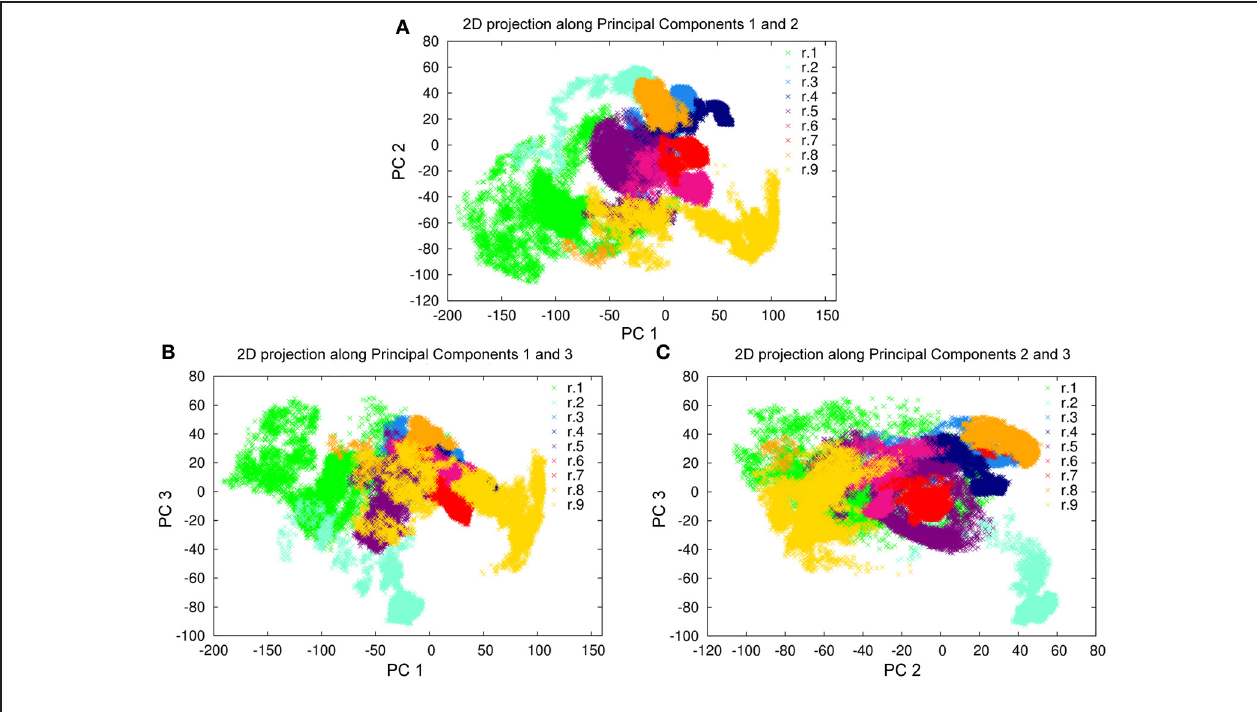
FIGURE 3 | Projections of the MD trajectories of Sic1 KID on the first 3PCs derived from PCA of the macro-trajectory. (A) First ( x axis) and second ( y axis) eigenvectors, (B) first ( x axis) and third